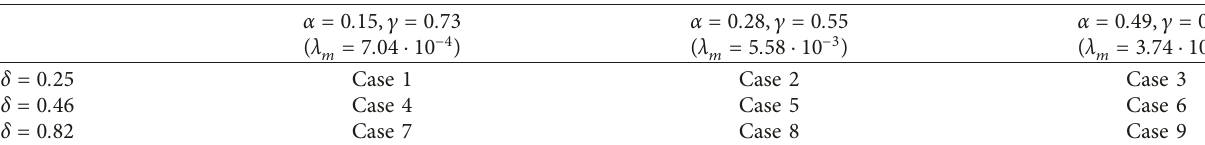
Table 2: Input data: case description.